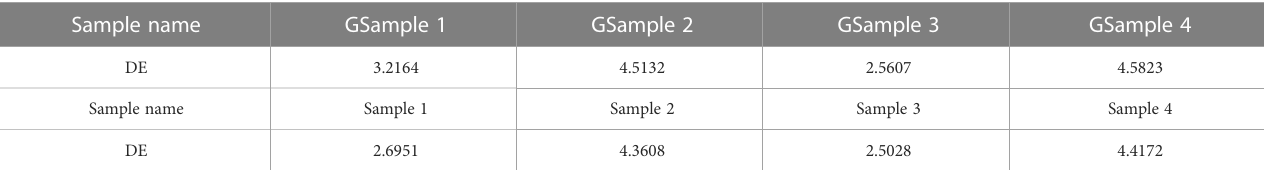
TABLE 4 Dispersion entropy